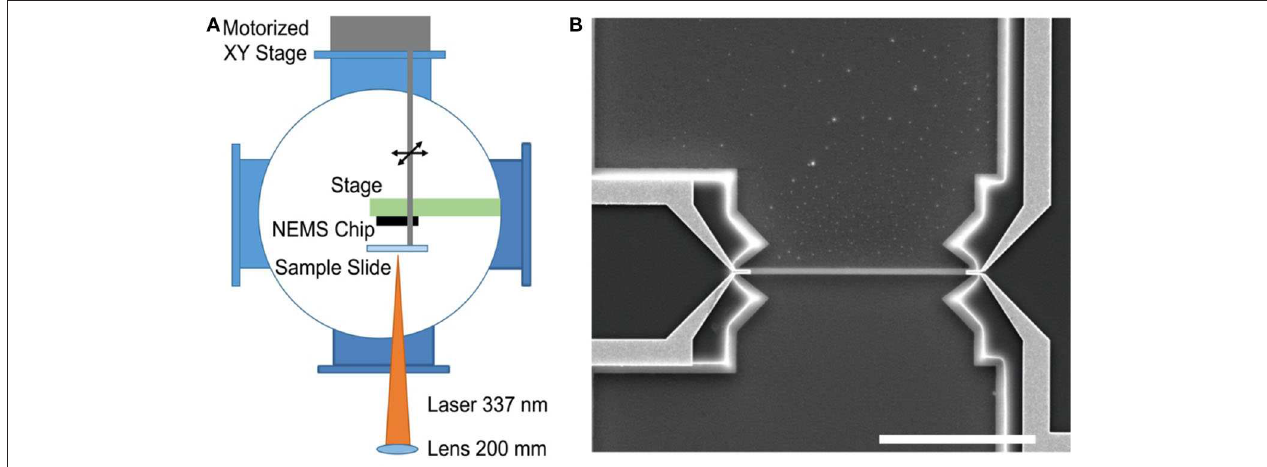
FIGURE 1 | Experimental setup. (A) Ultra high vacuum (UHV) system equipped with a motorized stage to scan the sample slide containing nanoparticles. The laser used for desorption is positioned outside the chamber and focused through an optical access on the vacuum chamber. (B) SEM image of a typical doubly-clamped beam resonator used in the experiments. The scale bar is 10 µ